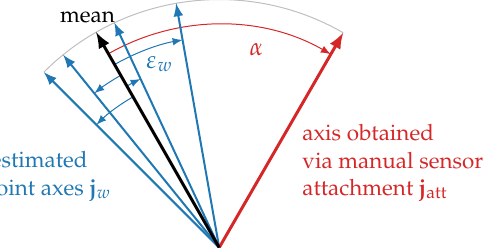
Figure 5. Variability angle ε w and misalignment angle α used to evaluate the axis estimation results. ε i is the angle between the estimated axis for a single window and the mean estimate. α is the angle between the mean estimate and the axis obtained by careful manual sensor attachment. For a good anatomical calibration method, ε i should be small, showing that the estimates are consistent, and α should be within 30 ◦ , showing that the estimates are